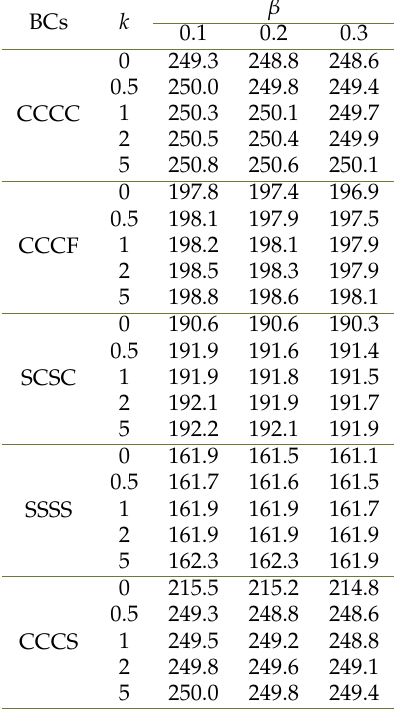
Table 3. Influences of the different BCs on the buckling load parameter of the square sandwich plate having a PEEK - 30% CF core, and two homogenous facings